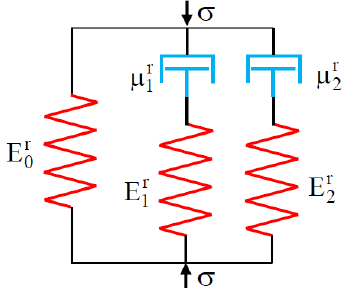
Figure 5. Maxwell–Wiechert stress relaxation model.